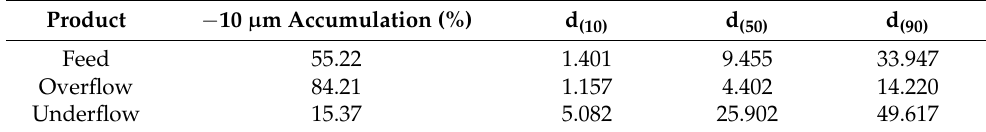
Figure 10. ( a ) The accumulation fraction of products; ( b ) the volume fraction of products. Product particle size analysis. Table 3. Particle size analysis.